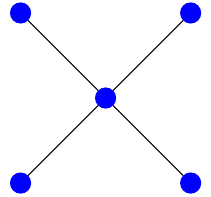
Figure 2. The star with five